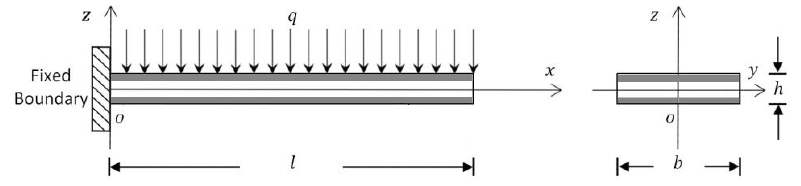
Fig. 1. Sketch of the three-layer composite cantilever beam system subjected to distributed load.